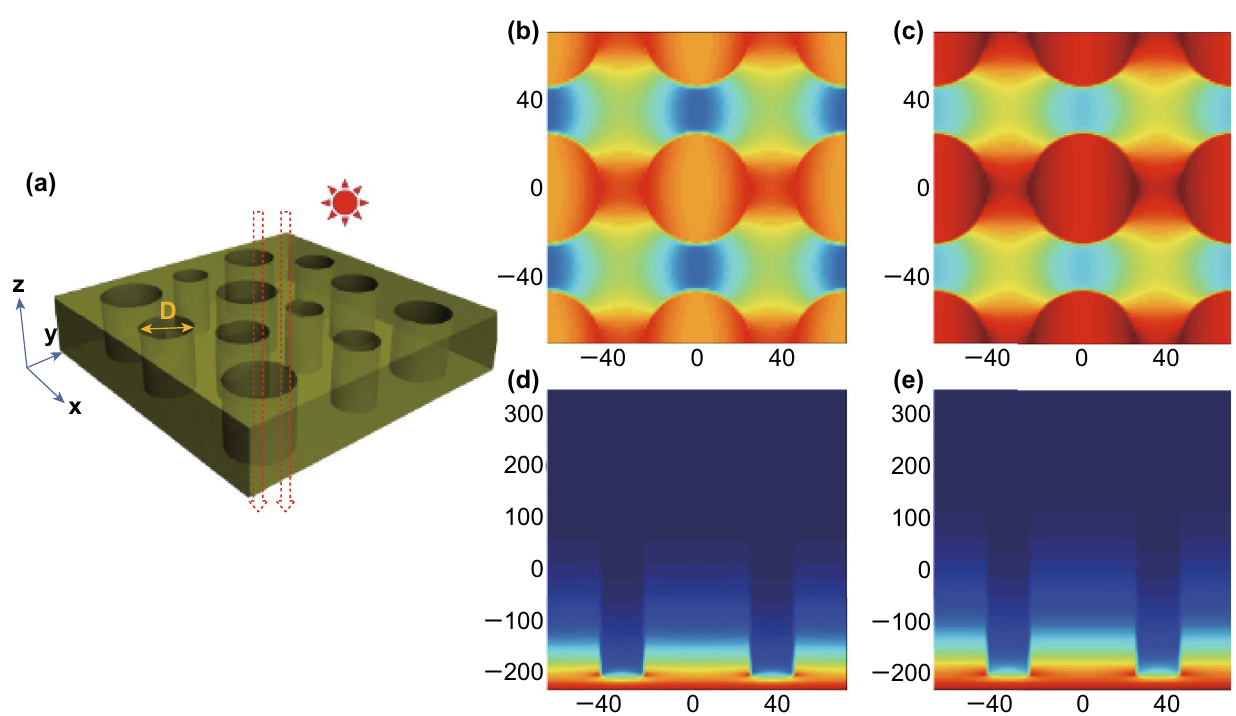
Fig. 11 a Simulation model of Mo-MCN. D represents mesopores of sizes ranging from 10 to 50 nm, and electric field intensity distribution in x–y plane for b P-CN, c Mo-MCN, and x–z plane for d P-CN, and e Mo-MCN (Color changing from blue to red reflects the electric field inten- sity